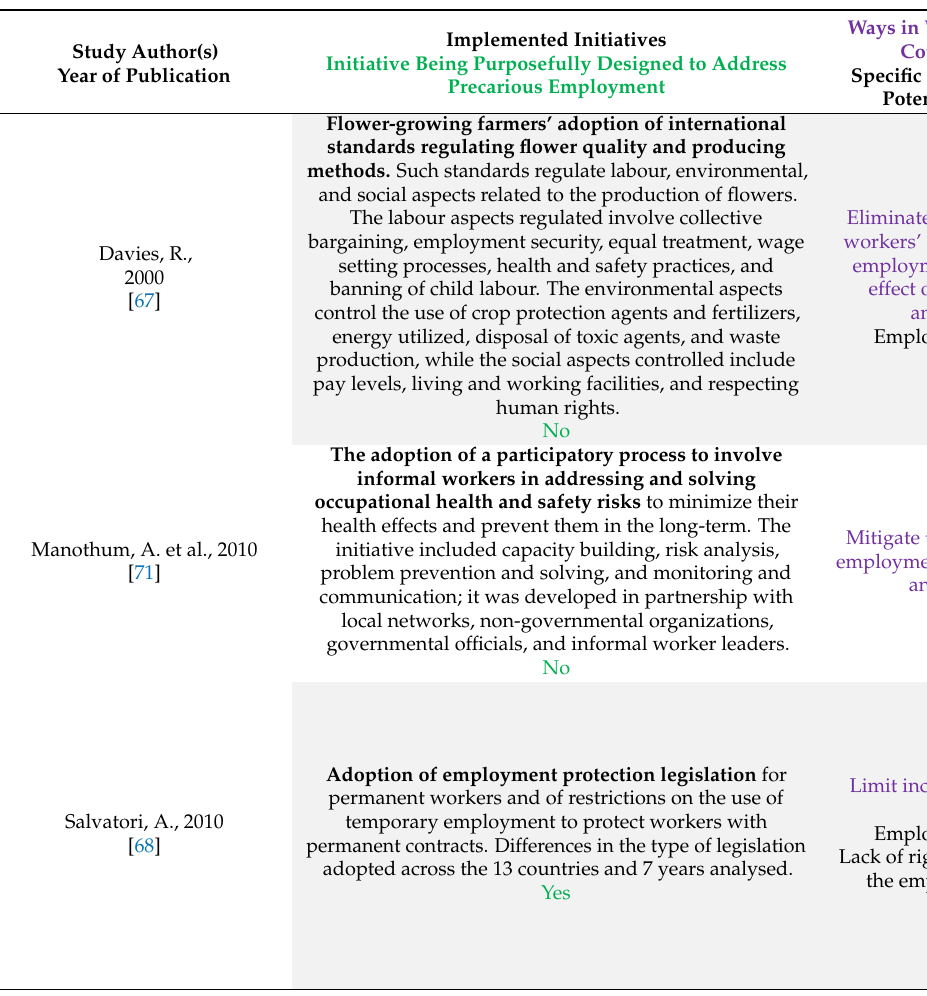
Table 3. Description of initiatives, ways in which they could impact PE, and design and data collection approaches used to evaluate